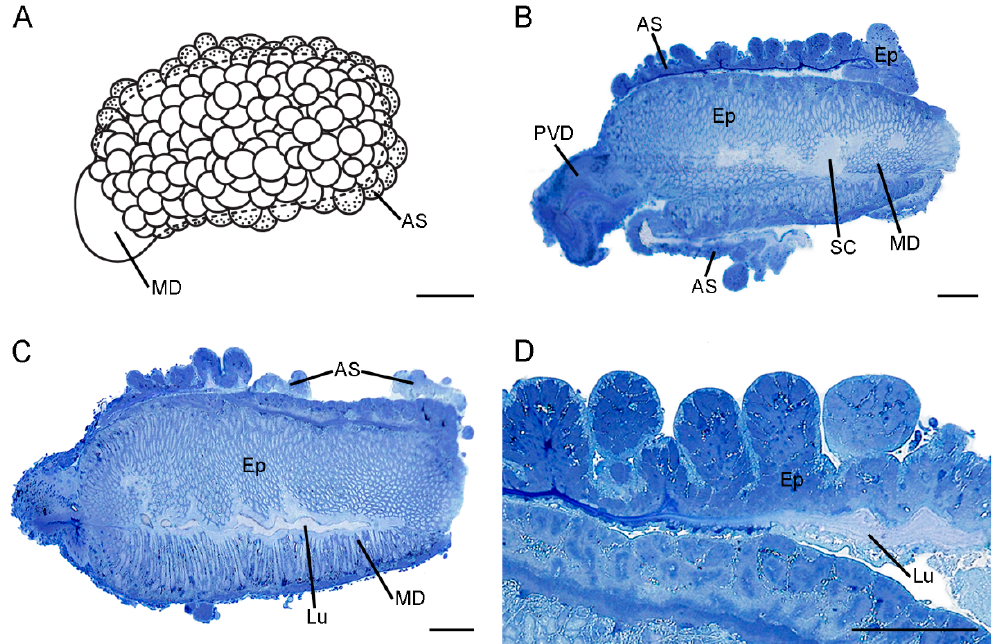
Figure 2. General morphology of the ejaculatory duct of Furcatopanorpa longihypovalva . ( A ) Schematic diagram of the habitus, showing the median duct and the accessory sac. ( B ) The accessory sac extends from ventral side of the median duct in the longitudinal section. ( C ) Longitudinal section showing the small lumen of the median duct. ( D ) A magnification of the chambers of accessory sac. AS, accessory sac; Ep, epithelium; Lu, lumen; MD, median duct; PVD, post-vesicular vas deferens; SC, subcuticular cavity. Scale bars: ( A ) = 200 μ m; ( B – D ) = 100 μ m.